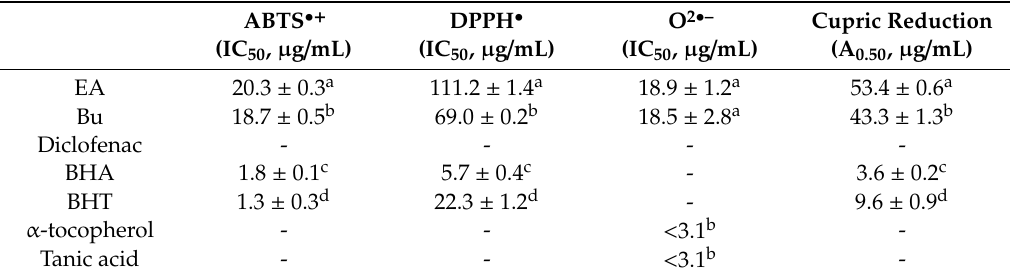
Table 3. Antioxidant activities of S. tenuipes fractions.